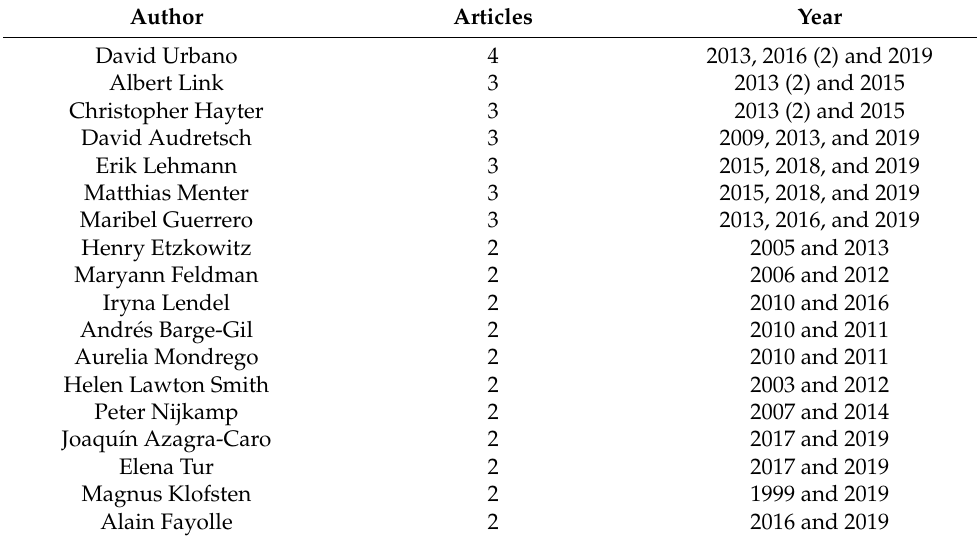
Table A1. Authors who participated in more than one article.